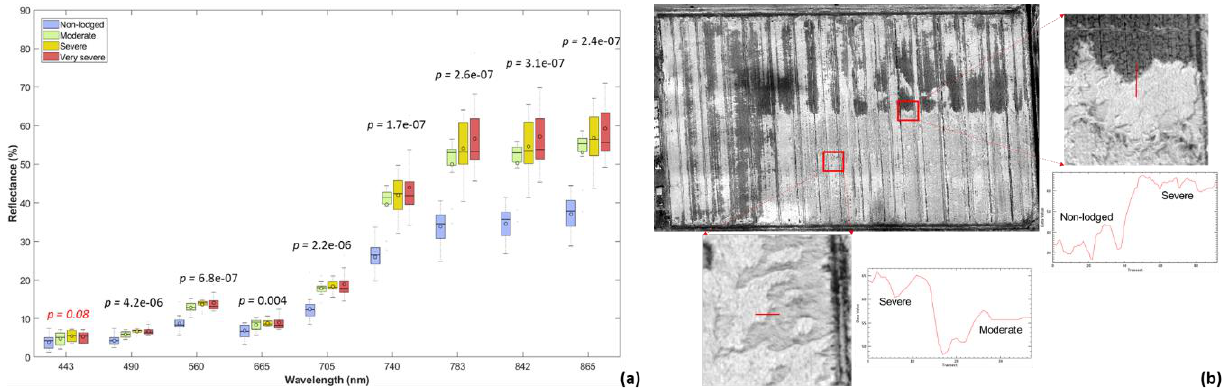
Figure 3. (a) Boxplot for field spectral reflectance at different wavelengths for different classes and (b) the transects of the pixels sampled from different classes in NIR1 (783nm)